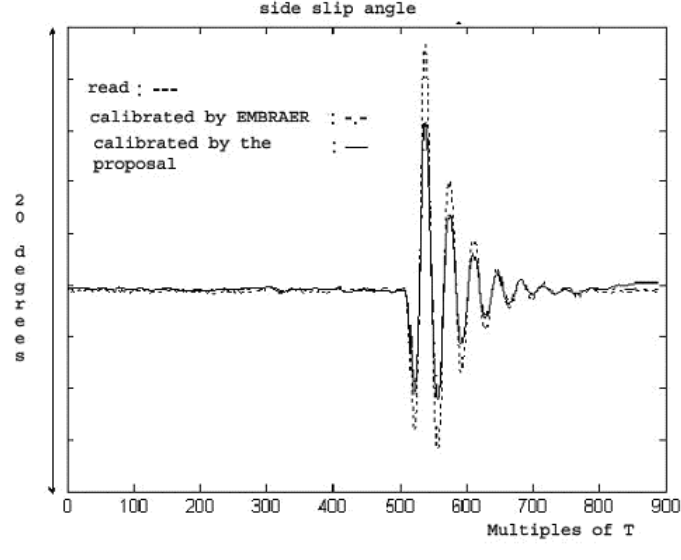
Fig. 5. Aileron deflection for the Dutch-roll maneuver.